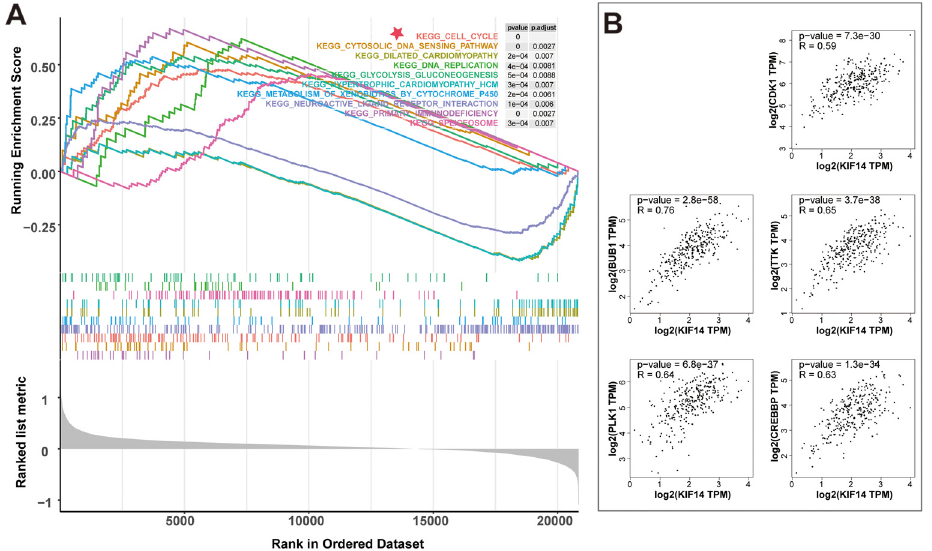
Figure 6. Identi fi cation of kinesin family member 14 (KIF14)-related signaling pathways by gene set enrichment analysis (GSEA). A , A merged enrichment plot is shown from GSEA including enrichment score, gene sets, and P values. Ten KIF14-related pathways are shown here. B , The correlation between KIF14 expression and the fi ve indexes of the cell cycle, including BUB1, TTK, PLK1, CREBBP, and CDK1, were analyzed using Gene Expression Pro fi ling Interactive Analysis (GEPIA).